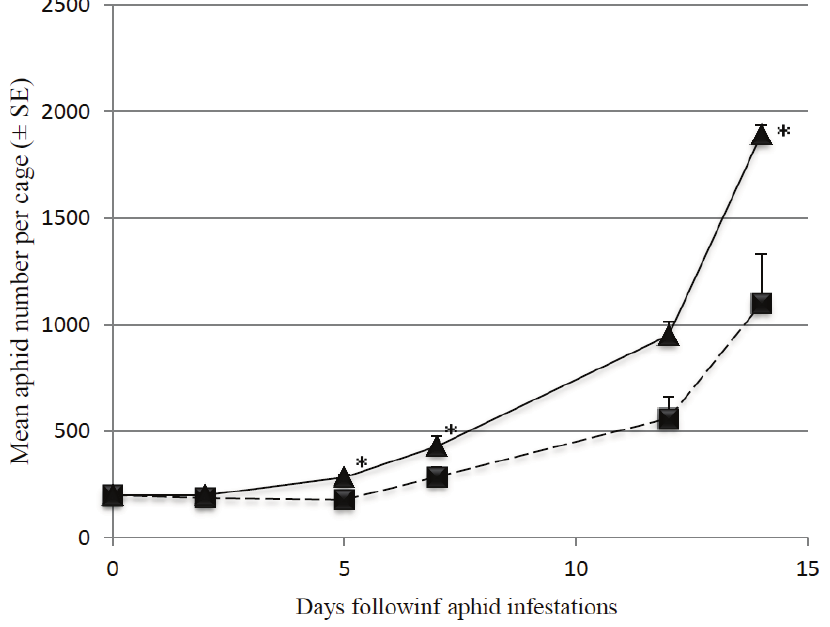
Figure 2. Evolution of mean aphid number ( n = 4) in presence (dashed line with square dots) and absence (plain line with triangle dots) of M. pygmaeus ; *, stars indicate mean aphid number statistically differing with M. pygmaeus